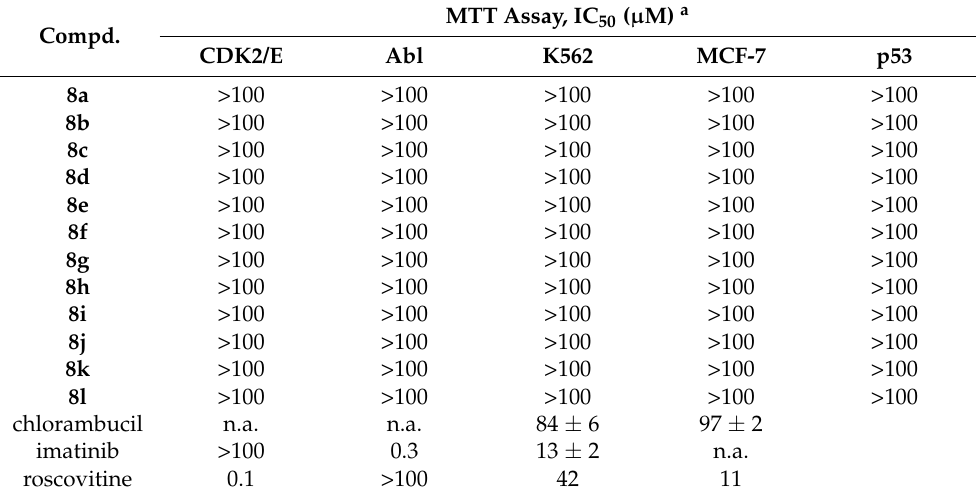
Table 4. Inhibition of protein kinase and antiproliferative activity of sulfonamide derivatives of pyrazolo[4,3- e ][1,2,4]triazines ( 8a – l ) after 24 h of incubation.